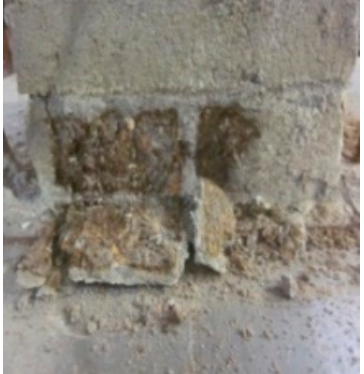
Figure 13. The feet of the corrosion specimen.